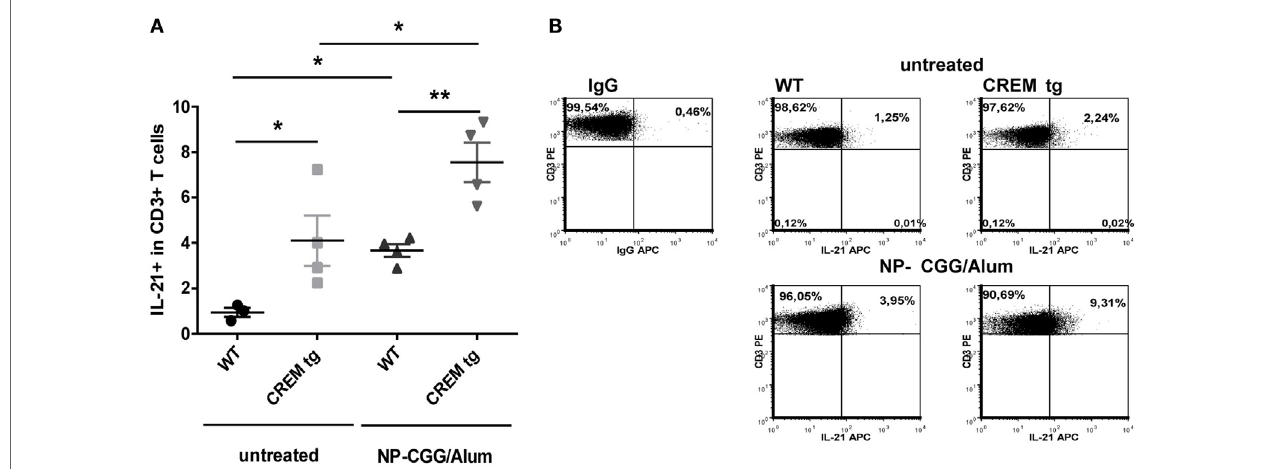
FigUre 1 | caMP-responsive element modulator alpha overexpressing T cells produce enhanced levels of il-21 . (a) Percentages of IL-21 + cells within CD3 + T cells in spleens of untreated mice or mice after immunization with NP-CGG/Alum. Data show mean percentage ± SEM, * p < 0.05. (B) Representative flow cytometric dot plots of IL-21 expressing CD3 + T-cells in a CD3 +